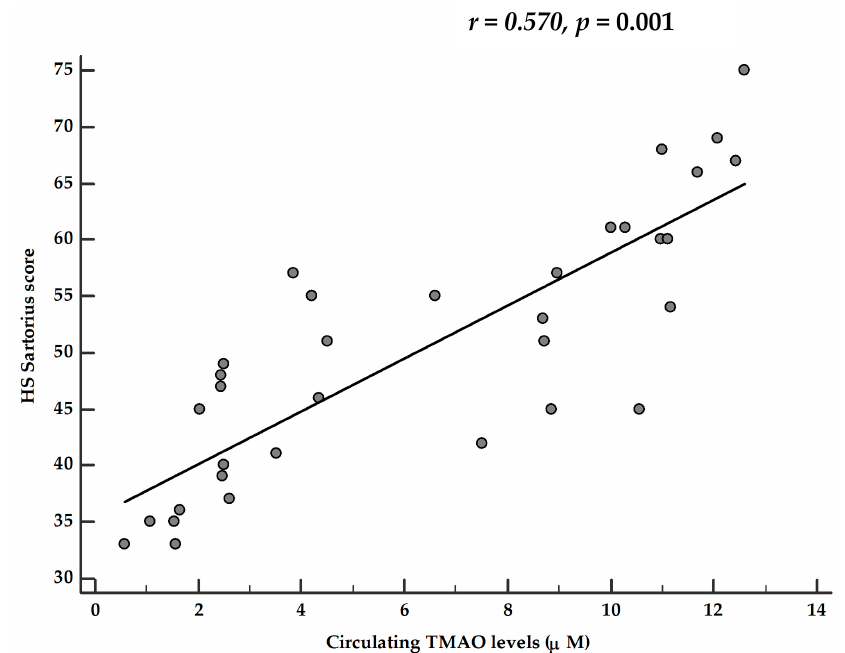
Figure 3. Partial correlation between HS Sartorius score and the circulating TMAO levels. HS Sartorius score was positively associated with the circulating TMAO levels, after adjusting for BMI, waist circumference, PREDIMED score, total energy intake, and PhA. Correlations between variables were performed using Pearson r correlation coefficients. A p value in bold type denotes a significant difference ( p < 0.05). HS, Hidradenitis Suppurativa; TMAO, trimethylamine n-oxide.